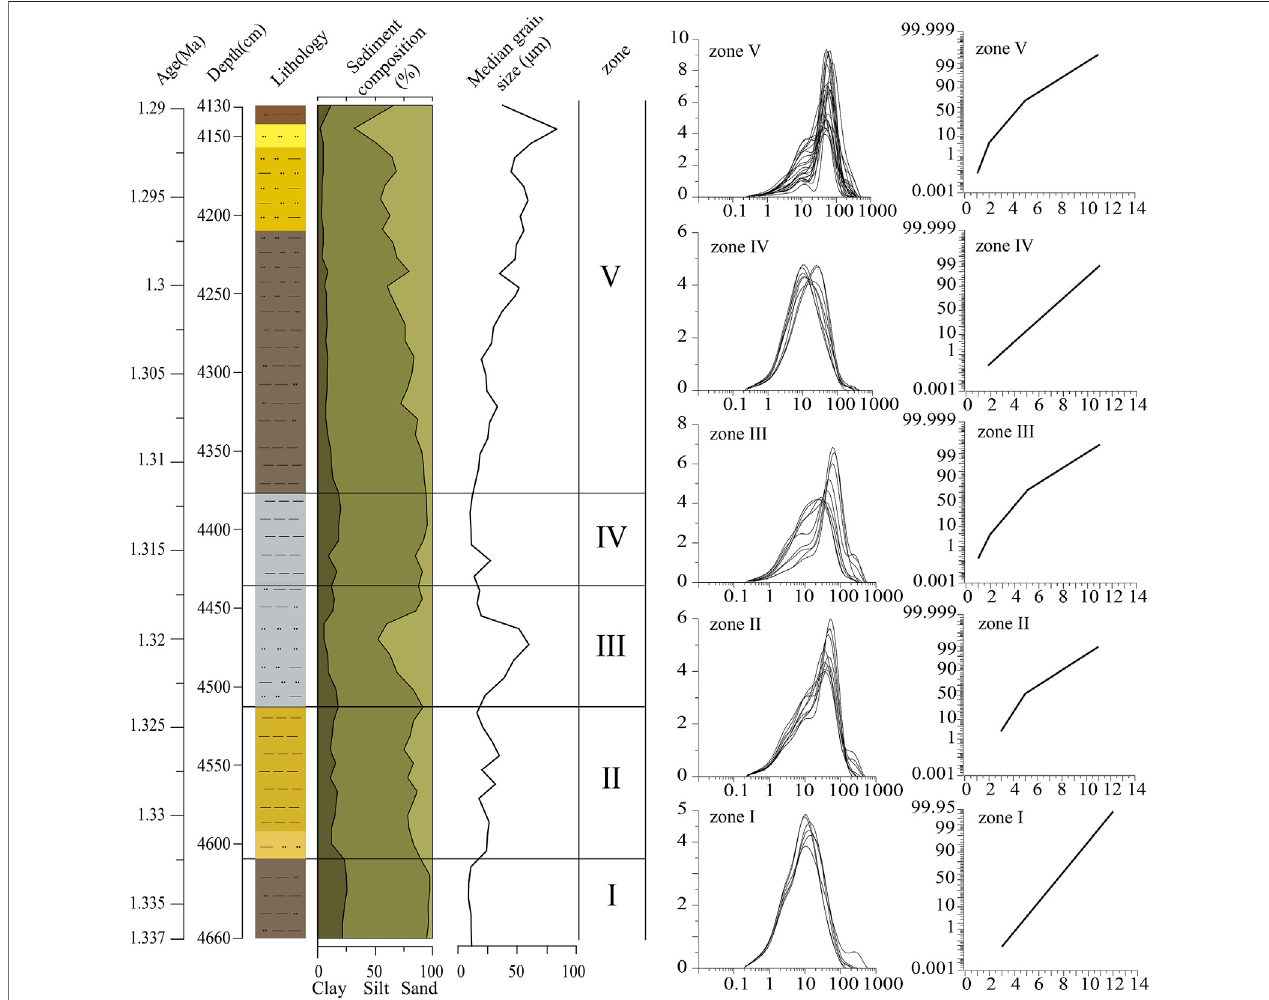
FIGURE 5 | Lithology, median grain-size pro fi le, and grain-size zones for the Banshan site. Representative grain-size frequency distribution and cumulative curves are shown on the right.